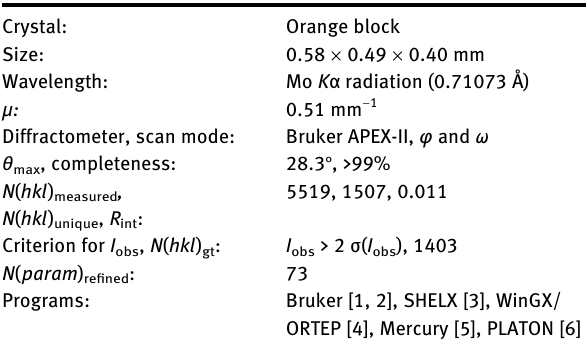
Table  : Data collection and handling.